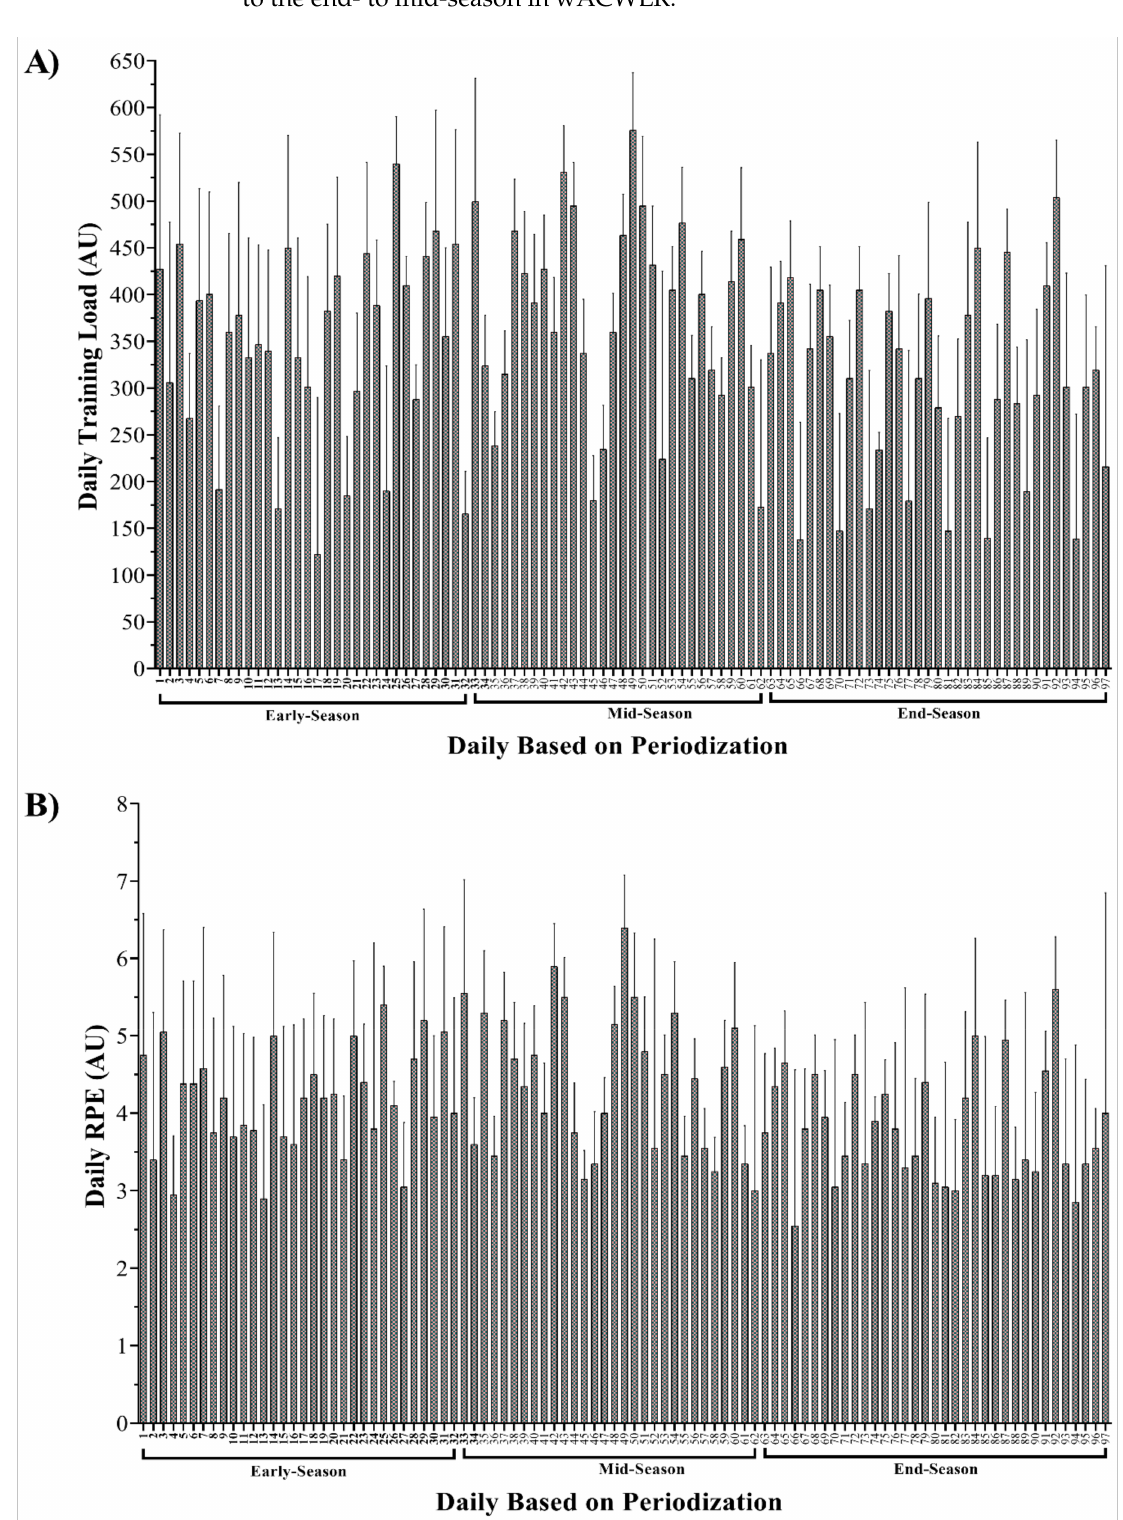
Figure 1. Fluctuations in session training load ( A ) and rating of perceived exertion (RPE, B ) over the